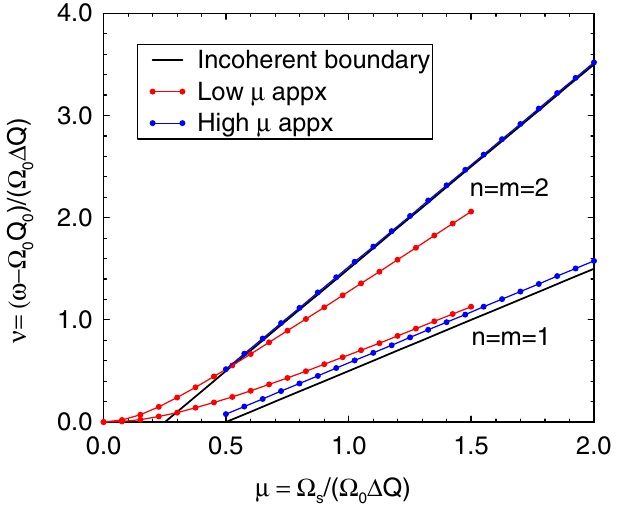
FIG. 17. (Color) The same as in Fig. 16 for the Gaussian bunch truncated on the 3 (cid:10) level.